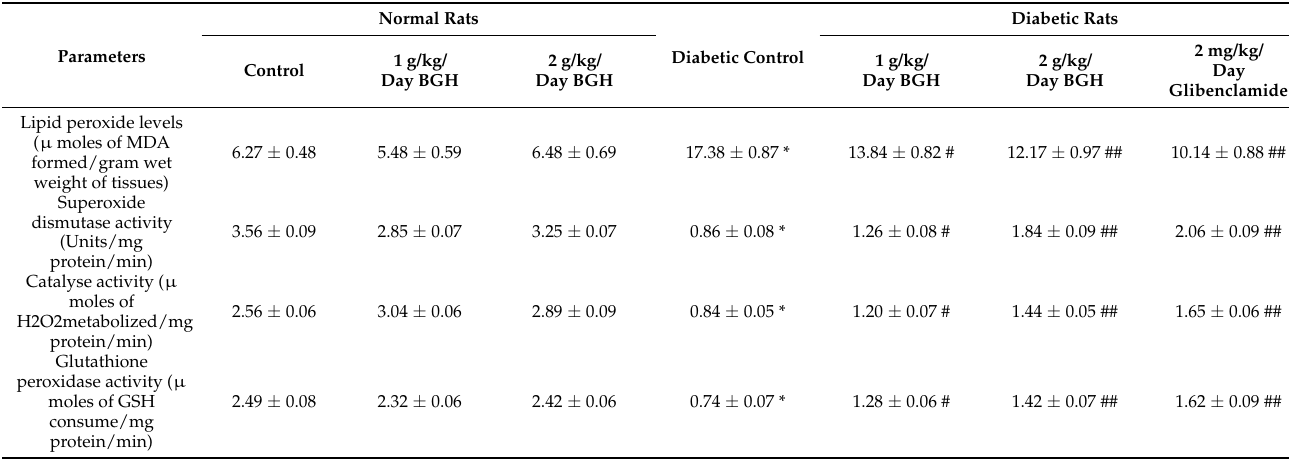
Table 3. Effect of BGH on lipid peroxidation levels, superoxide dismutase activity, catalyse activity, glutathione peroxidase activities in the liver of streptozotocin–nicotinamide-induced diabetic rats. Normal Rats Diabetic Rats Parameters Diabetic Control